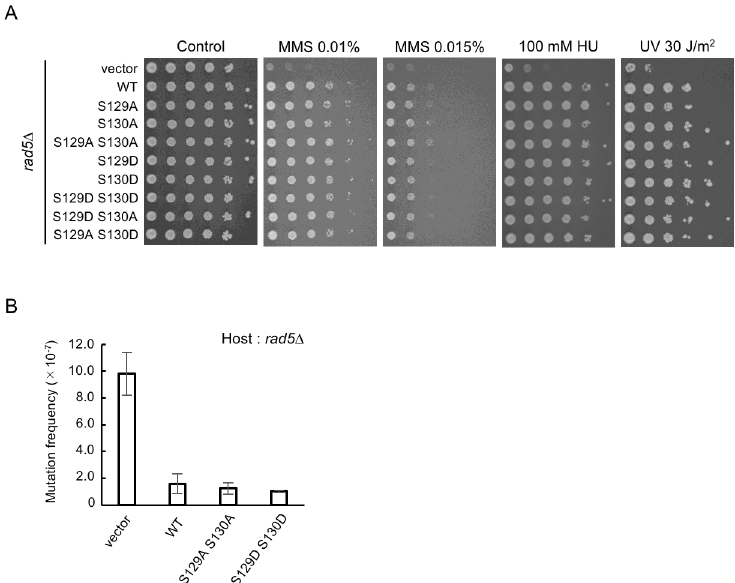
Fig 3. Functional analysis of Rad5 phosphorylation in DNA damage tolerance pathways. (A) DNA damage sensitivity of rad5 mutants. rad5 Δ cells carrying each of the indicated plasmids were 10-fold serially diluted and exposed to the indicated DNA-damaging agents, and plates were incubated at 30˚C for 3 days. (B) Mutation frequencies at the CAN1 locus in rad5 Δ cells carrying the indicated plasmids. Cells were grown in SC-LEU medium at 30˚C. Canavanine-resistant mutants were selected on synthetic complete medium lacking leucine and arginine, and containing canavanine. Error bars indicate the standard errors of the three independent